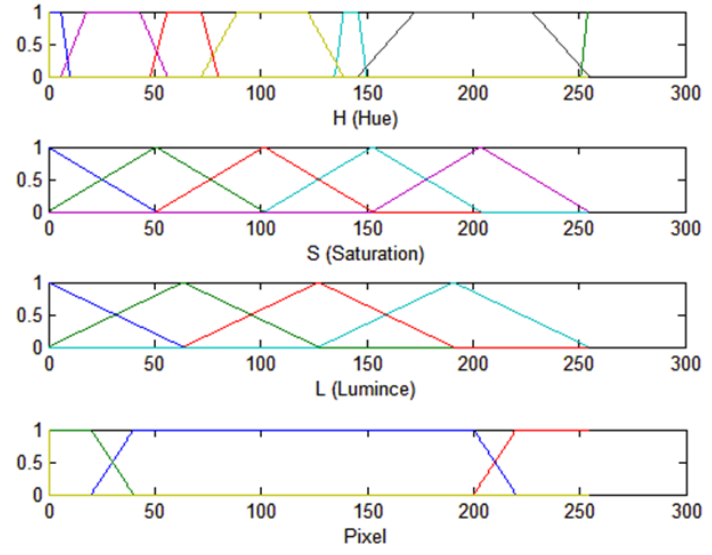
Figure 3. Fuzzy sets of color classification system.